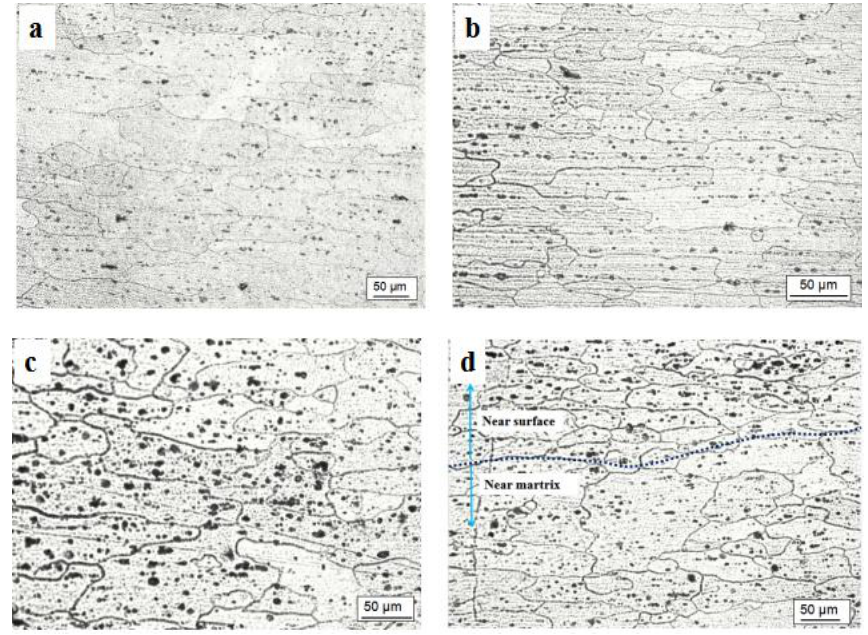
Figure 7. Microstructure: ( a ) untreated; ( b ) LP; ( c ) WLP in Area A; ( d ) WLP in Area B.